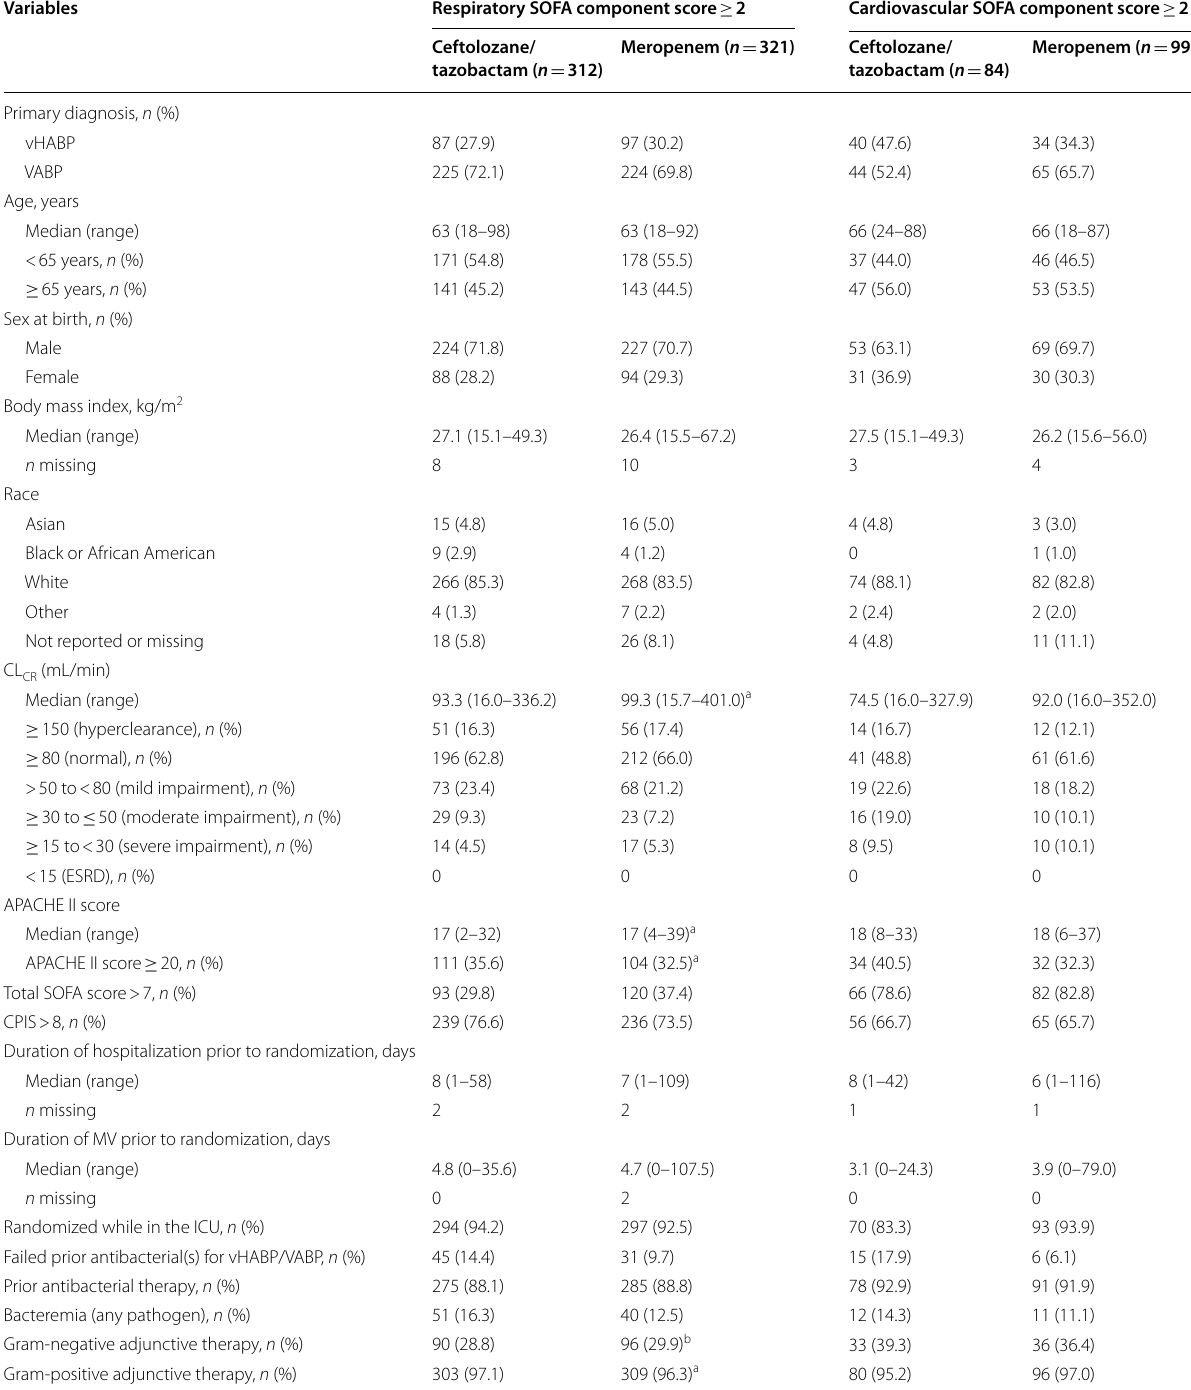
2 or CV‑SOFA 2 (ITT ≥ ≥